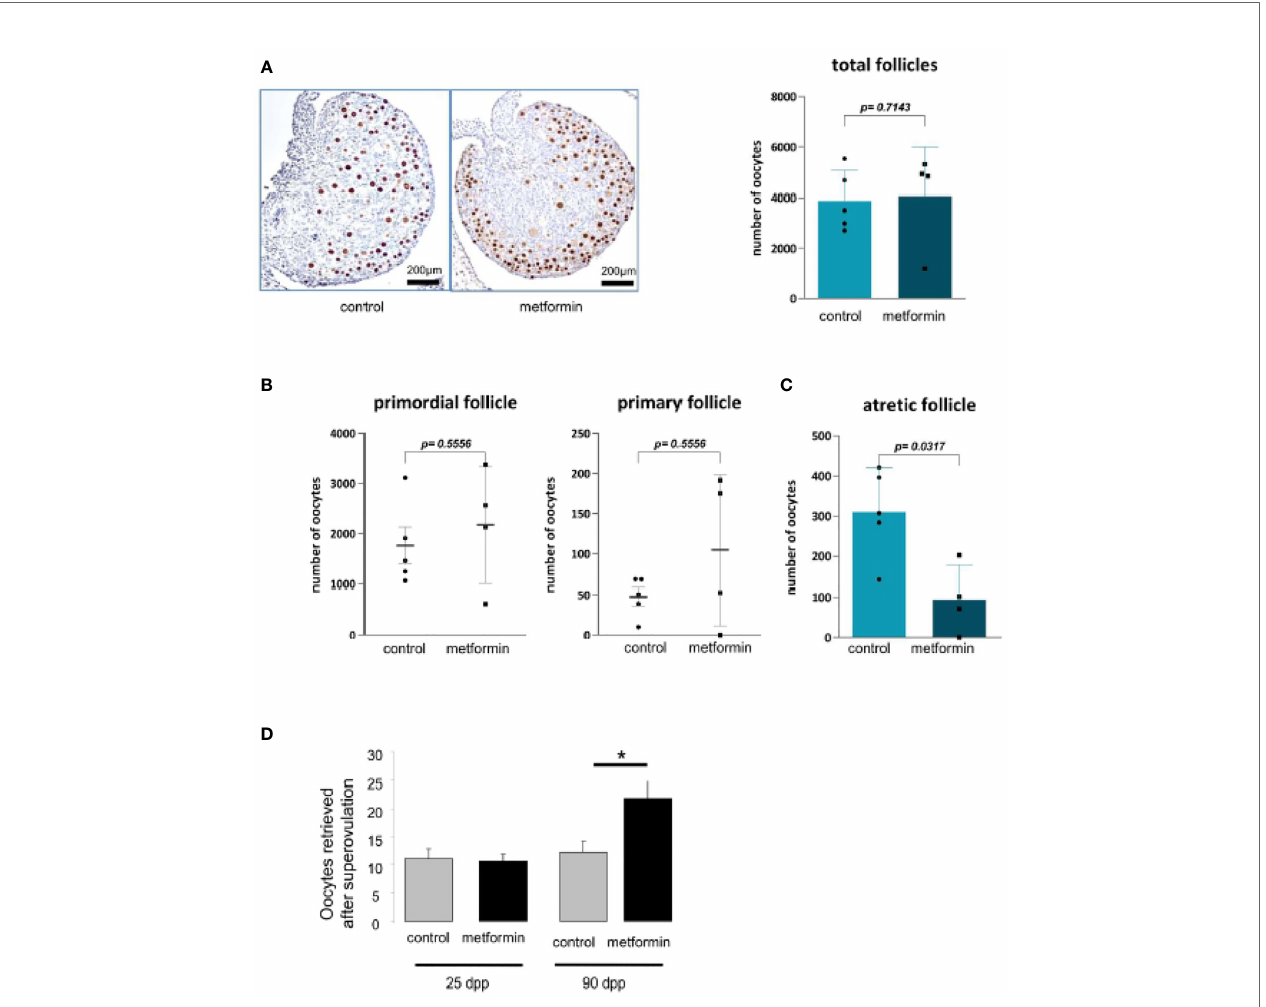
FIGURE 7 | Morphology of ovary at birth. (A) Number of oocytes was measured on ovary from 2 dpp old female mice after a P63 immunostaining (n=5). (B) The quanti fi cation of follicle number was performed after a staining of ovarian section with haematoxylin – eosin. Follicles were classi fi ed according to the shape and number of layers of somatic cells surrounding the oocyte: primordial ( fl attened cells), and primary (one layer of cuboidal cells). (C) Quanti fi cation of atretic follicles (D) and number of oocytes retrieved after superovulation at 24 dpp and 90 dpp. Scale bar= 200 µm. White arrow indicates positive cell. *p <